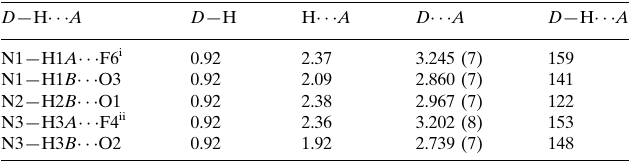
Hydrogen-bond geometry (A˚ , (cid:2)